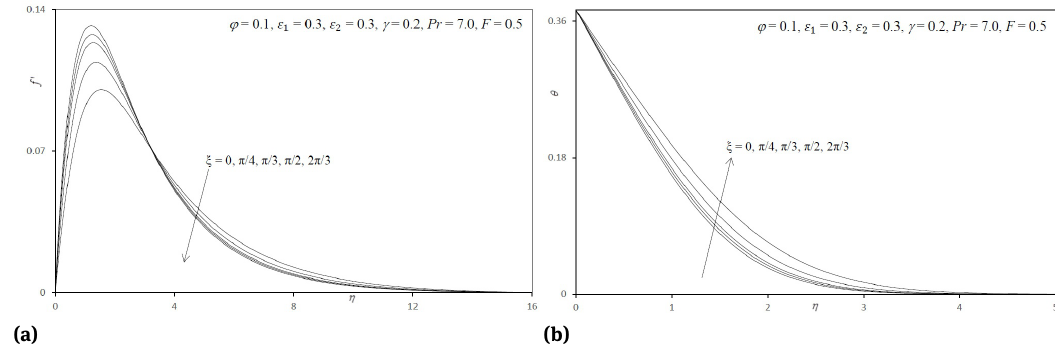
Fig. 8: (a) Effect of ξ on Velocity Profiles; (b) Effect of ξ on Temperature Profiles